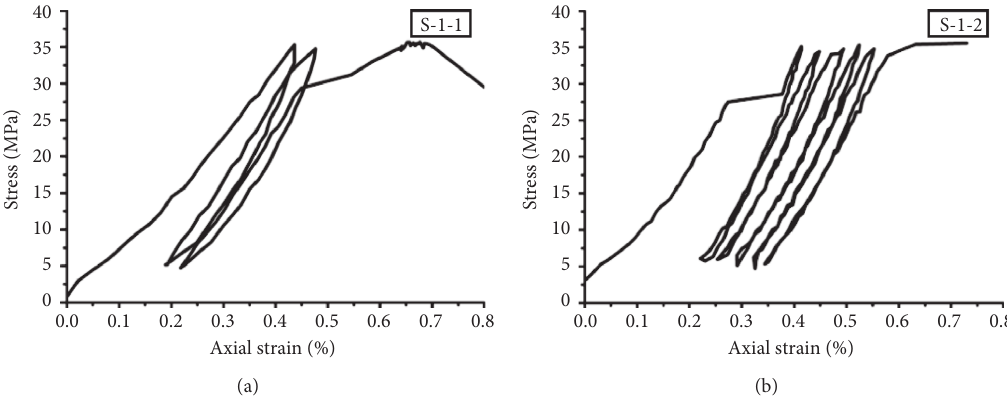
Figure 12: The stress-strain curves of S-1 rock sample group under cyclic loading and unloading (5–35MPa). (a) S-1-1 sample. (b) S-1-2 sample.